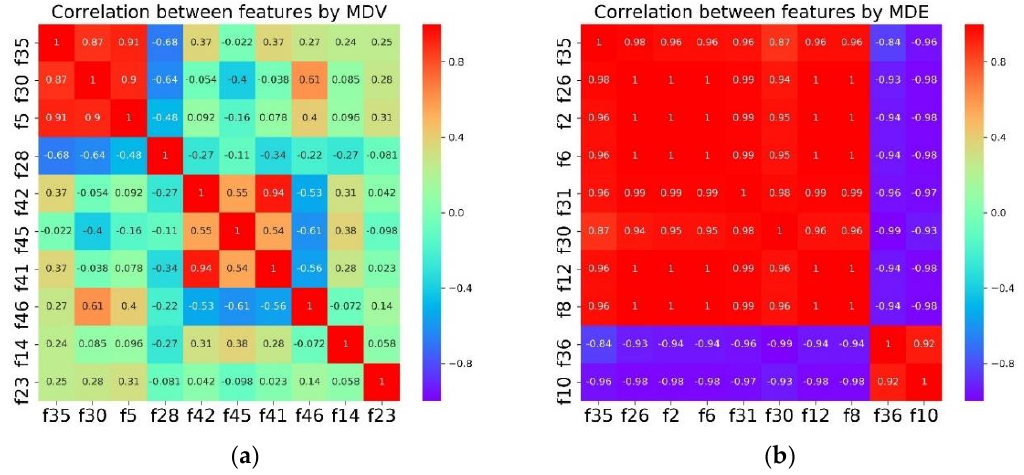
Figure 5. Pool and superior features against 16 flight states.